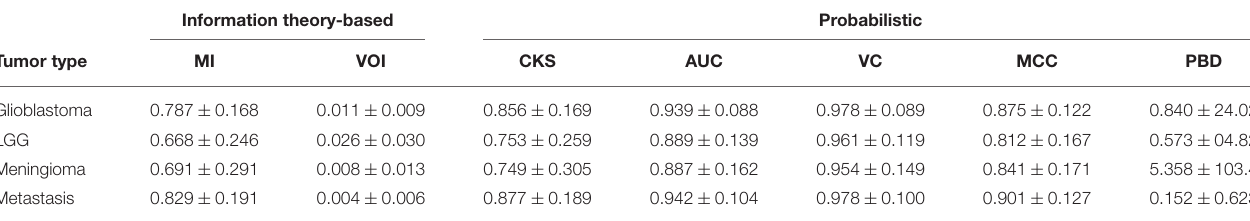
TABLE 6 | Voxel-wise performance summary for each tumor type for information theory-based and probabilistic metrics.